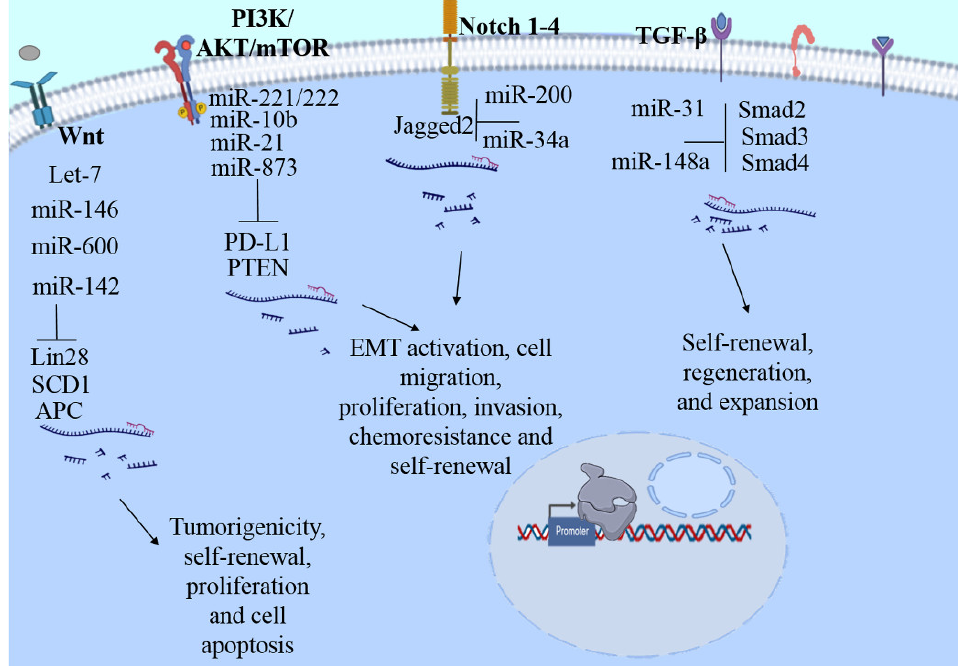
Figure 1. Main signaling pathways modulated by miRNAs in bCSC. Stem cell maintenance is complex and highly regulated processes, several pathways are essential for the maintenance of bCSC, including NF-κB, PI3K/AKT/mTOR, Notch, Hedgehog, Wnt, Hippo, JAK/STAT, TGF-β, and signaling estrogen receptor-mediated. Deregulation of these pathways can be one of the main reasons for the appearance or exacerbation of the main hallmarks such as maintenance, self-renewal, tumor resistance, relapse, recurrence, aggressiveness, and metastasis of bCSC, among others. Some targets modulated by miRNAs: Wnt, stearoyl desaturase 1 (SCD1), Adenomatous polyposis coli (APC), Lin28; Notch, Jagged2; PI3K//AKT/mTOR, phosphatase and tensin homolog (PTEN) programmed cell death ligand 1 (PD-L1), and TGF-β, SMAD 2-4. Table 2. MiRNAs implicate in the bCSC